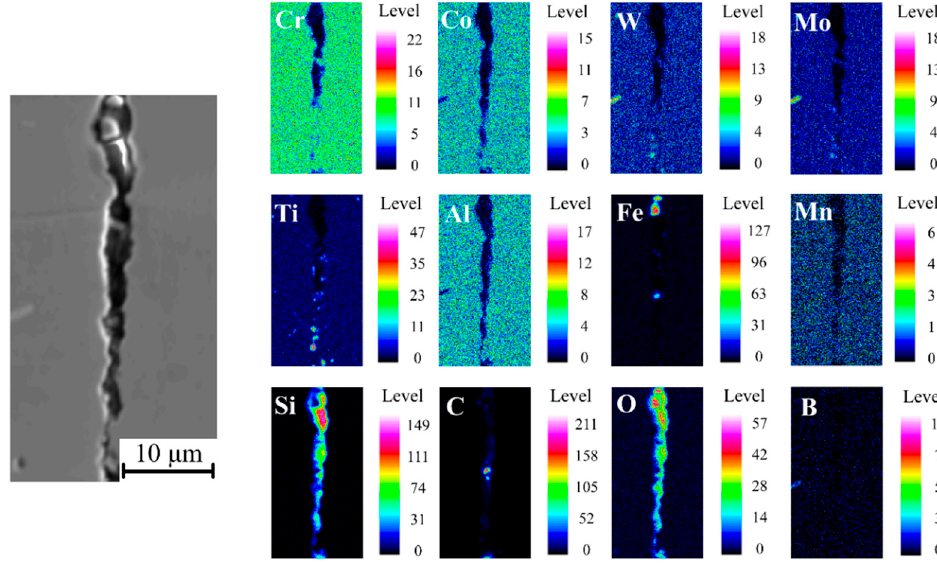
Figure 13. Series of elemental maps by EPMA showing the distribution near cracks of key elements in an as-EBM PREPed GH4099 superalloy. The colored scale bar at the right shows relative concentration, showing Si and O enrichment. Map conditions: 0.2 µ m step size both in x and y, 20 kV. Cloots et al. [48] revealed that cracks of IN738LC samples processed by selective laser melting propagate along building direction and distribute in a large grain boundary.